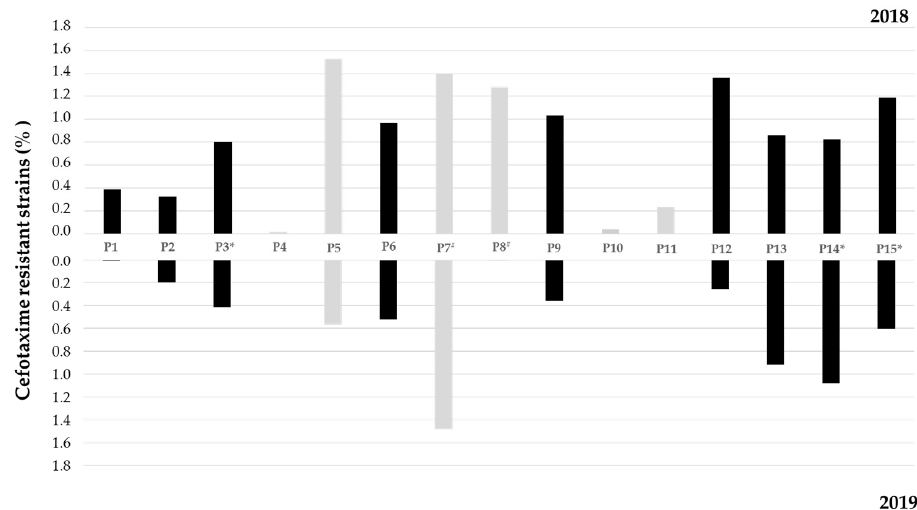
Figure 2. Proportion of cefotaxime-resistant bacteria determined in all sampling sites located in the Lis River from spring (P1) to mouth (P15) (P1–P3, P6, P9, P12–P15; black) and three affluents (P4/P5, P7/P8, and P10/P11; light grey); Sites located downstream WWTP and in the vicinities of pig farms are indicated by * and #, respectively.